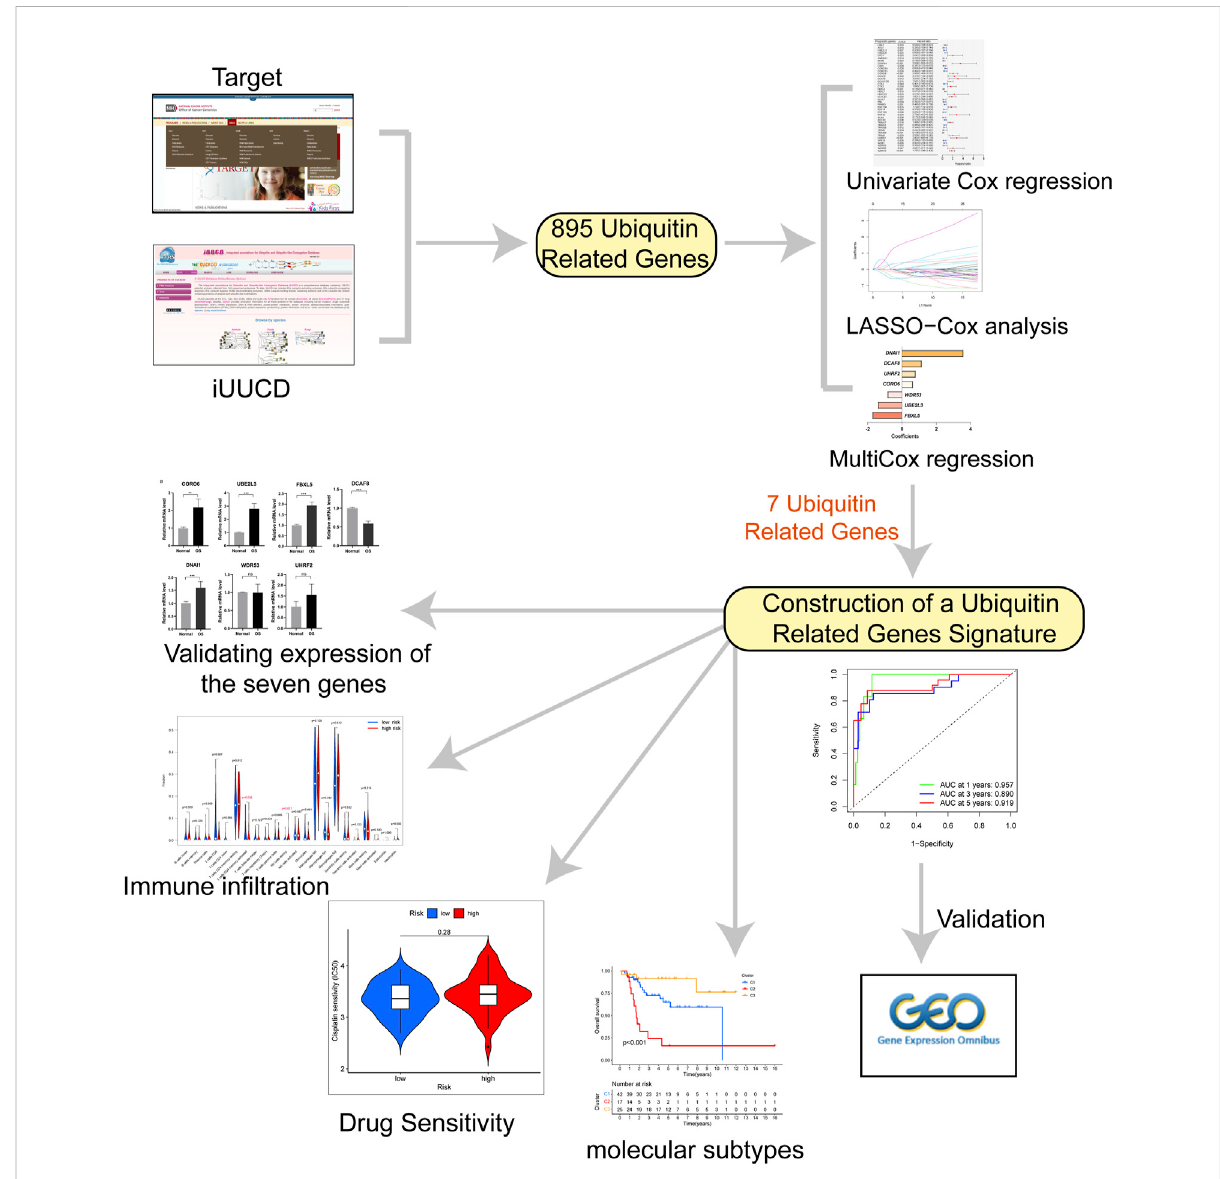
FIGURE 1 The fl ow chart for this